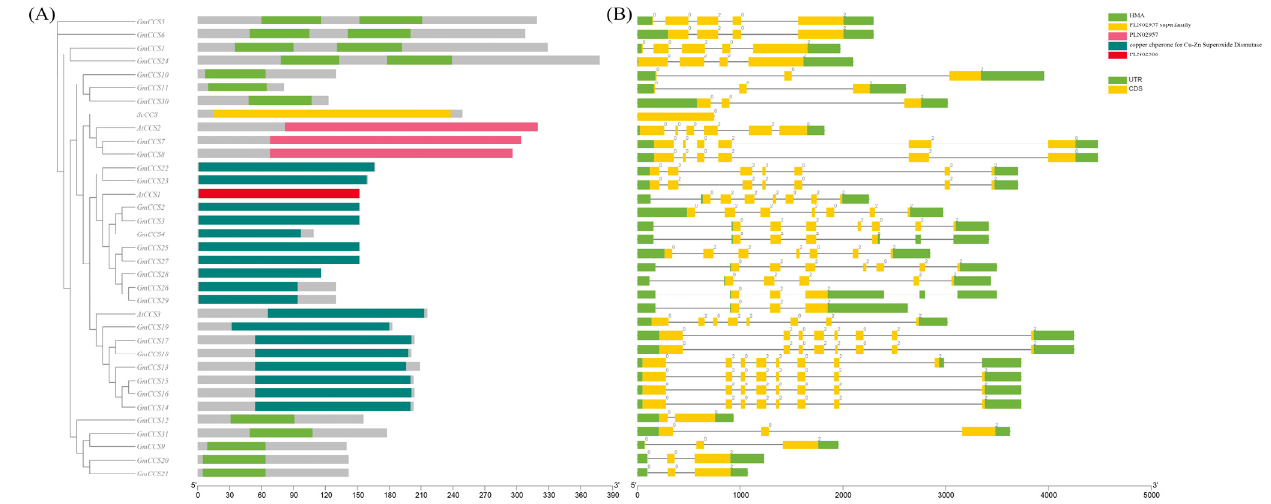
Figure 3. Gene structure, consvered domain analysis of GmCCS proteins from Glycine (G.) max. ( A ) The conserved domain in the GmCCS proteins. The green boxes indicate HMA domain (heavy- metal-associated), blue boxes respectively indicate Cu-zine (Zn) superoxide dismutase and the grey box indicate non-specific functional area. ( B ) The UTR, CDS and intron organization of GmCCSs. The green boxes represent UTRs, the yellow boxes represent CDS and thin black lines represent introns.